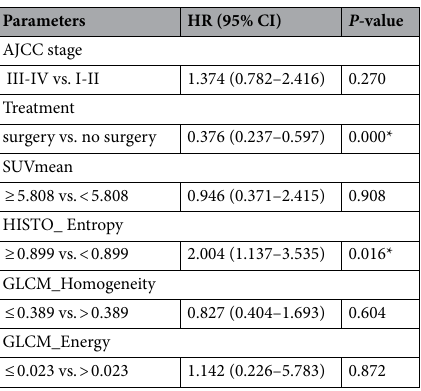
Table 5. Multivariate Cox regression analysis of RFS. HR hazard ratio, CI confidence interval, AJCC American joint committee of cancer, SUV standardized uptake value, HISTO histogram, GLCM grey level co-occurrence matrix. *Significant P -value (<